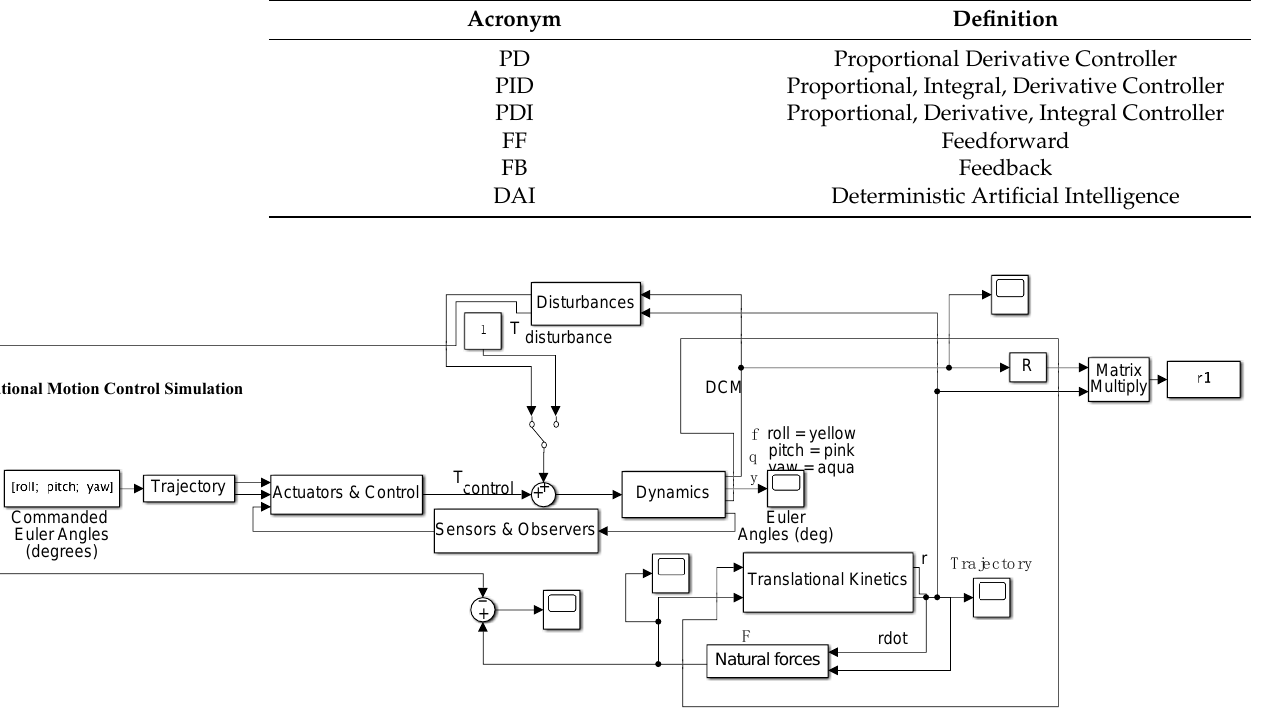
Figure A1. Simulink Model Complete display of all SIMULINK systems and subsystems.